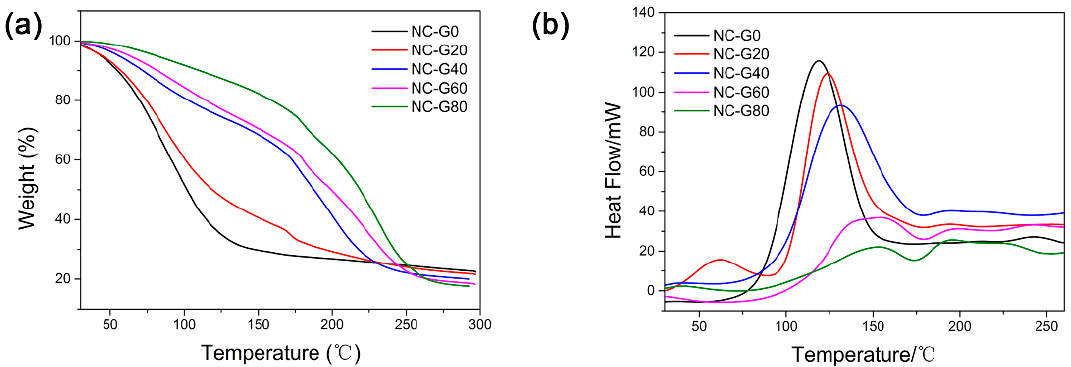
Figure 4. ( a ) Thermal gravimetric analysis (TGA) and ( b ) differential scanning calorimetry (DSC) curves of NC-G gels.